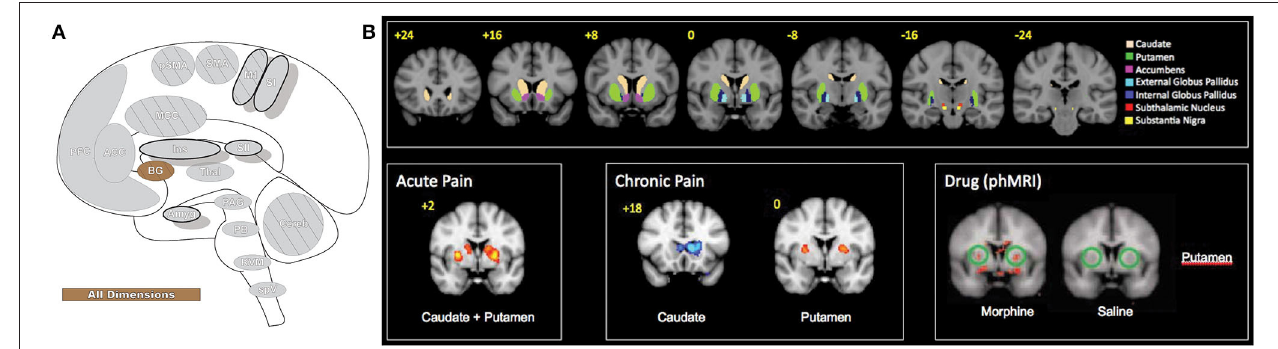
FIGURE 10 | Basal ganglia. (A) Brain areas active during pain: basal ganglia (BG) highlighted. (B) The basal ganglia participate in pain processing, from acute pain and chronic pain (cold and brush neuropathic allodynia) to morphine-induced analgesia, as revealed by pain-related patterns of fMRI BOLD activity. Upper panels: BG parcellations are color-coded and highlighted in coronal sections organized from anterior to posterior. Bottom panels: red areas indicate increased fMRI BOLD activation and blue areas indicate decreased activation. phMRI, pharmacological MRI- wherein pharmacological agents/drugs (in this case morphine) are used as stimuli to induce hemodynamic changes that are subsequently assessed by fMRI. Reprinted from Molecular Pain, Vol 6(27), D Borsook, J Upadhyay, EH Chudler, L Becerra, A key role of the basal ganglia in pain and analgesia–insights gained through human functional imaging, Copyright (2010) Borsook et al, under the Creative Commons Attribution License (CC-BY). DOI: